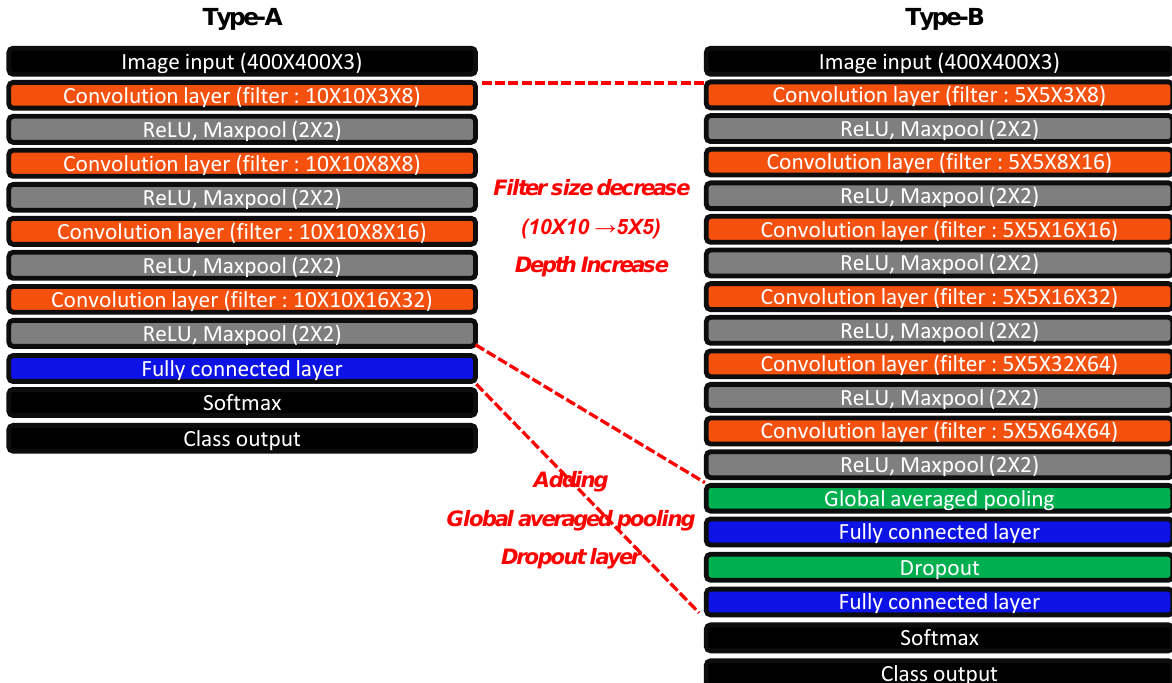
Figure 8. Comparison of two types of CNN architecture